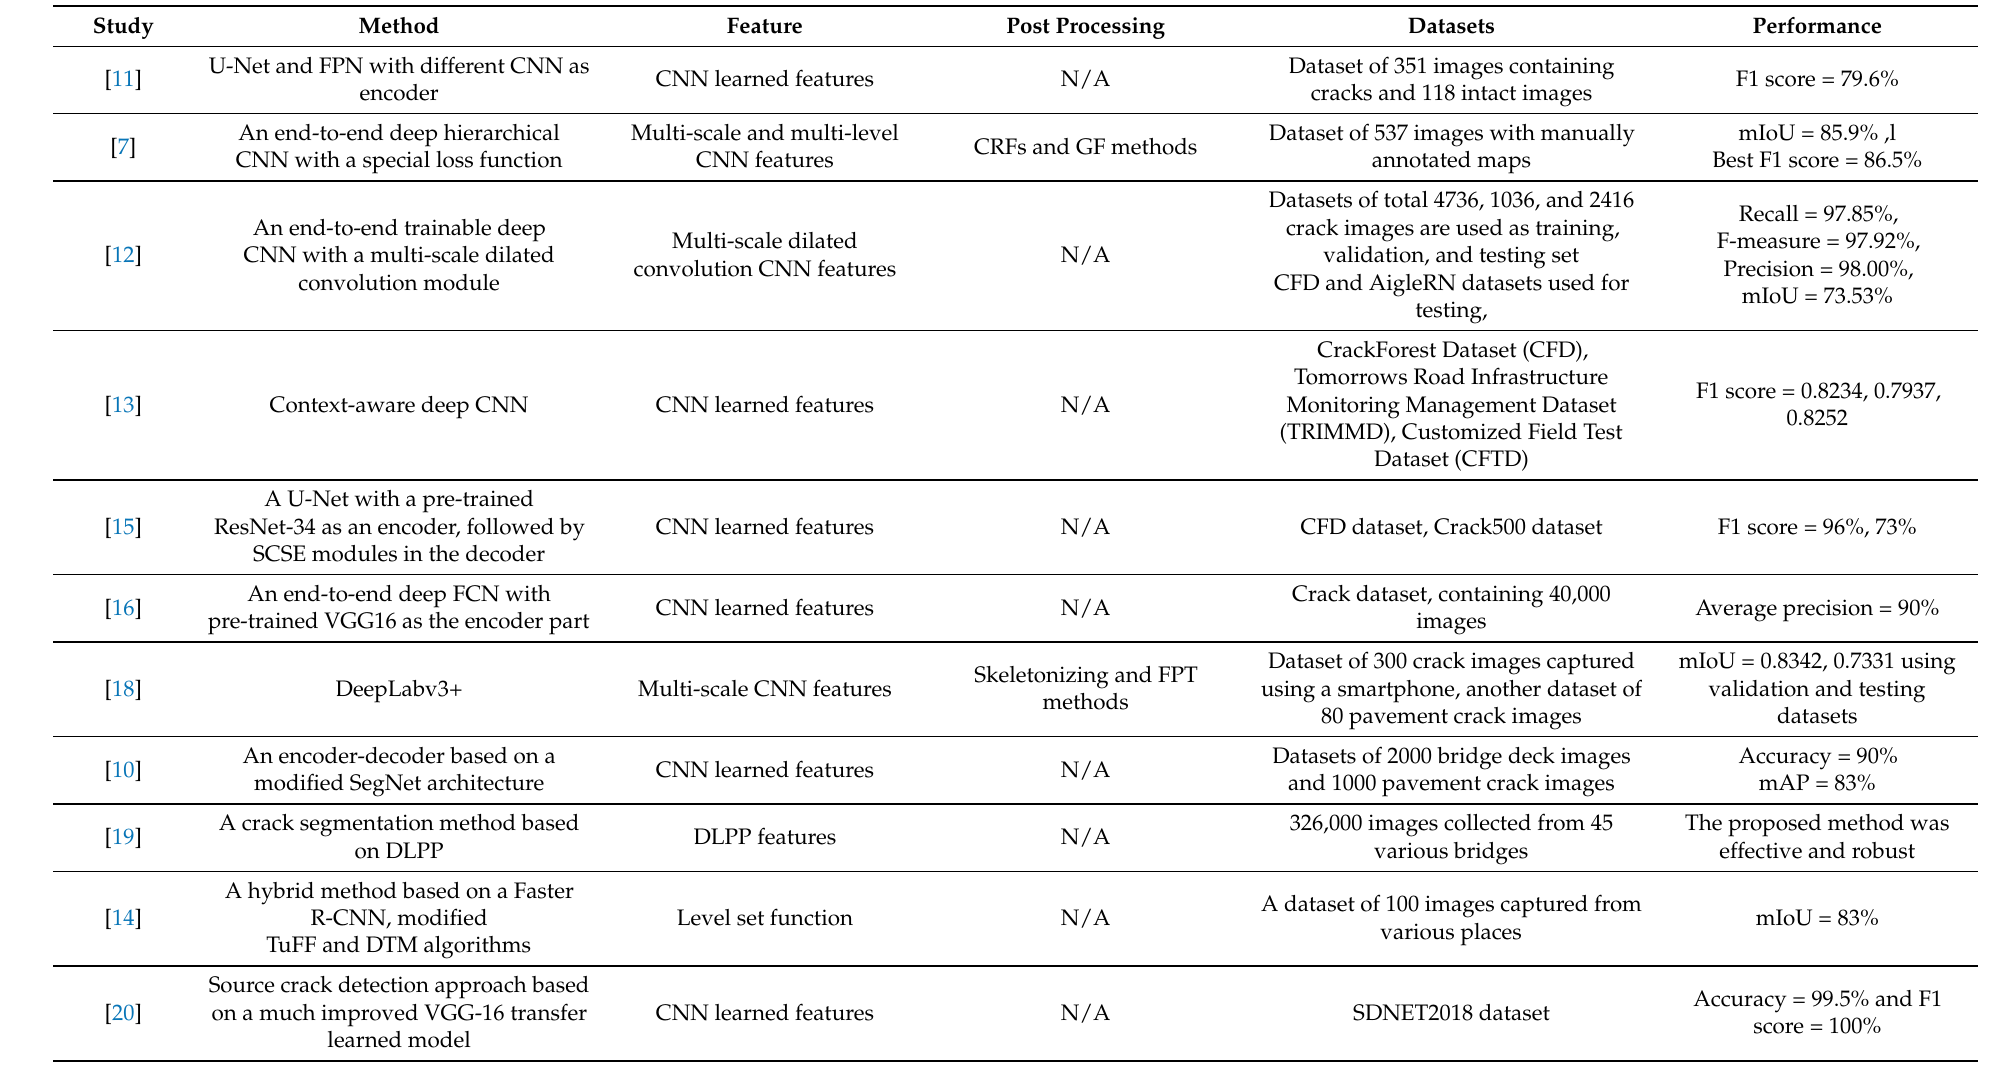
Table 1. Summary of surveyed state-of-the-art studies for crack segmentation approaches (N/A: not